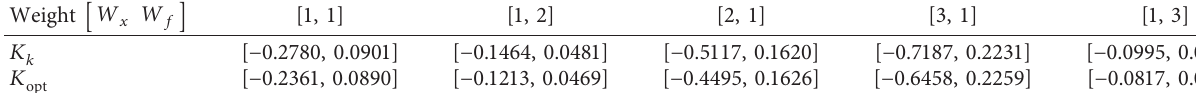
Figure 11: Euclidean norm value of P Table 2: K K values in the condition with different weights. k and opt